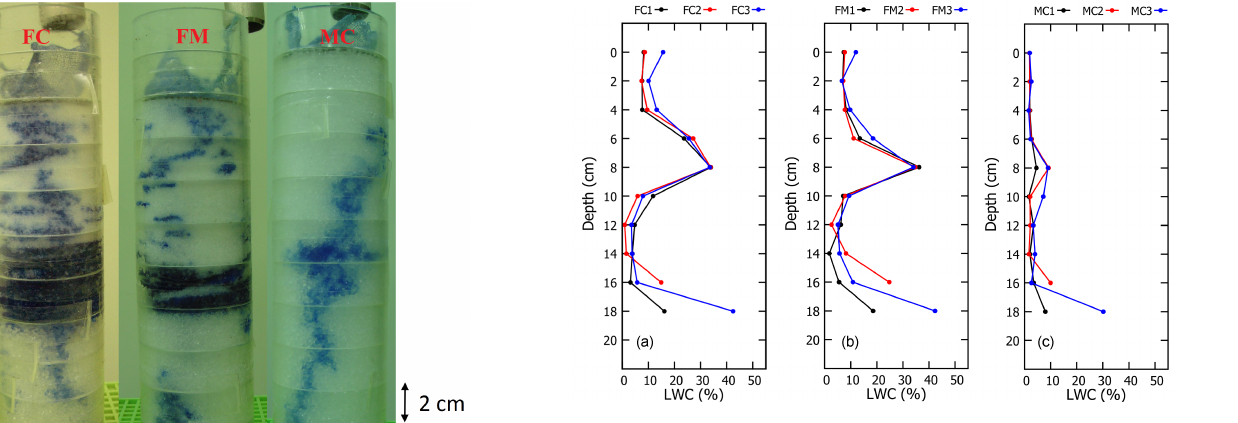
Figure 4. Measured LWC (vol%). (a) FC samples; (b) FM samples; (c) MC samples. Each point represents bulk LWC in the underlying 2cm. This convention is consistent with Figs. 1 and 3. Serial num- bering 1–3 represent the three different input